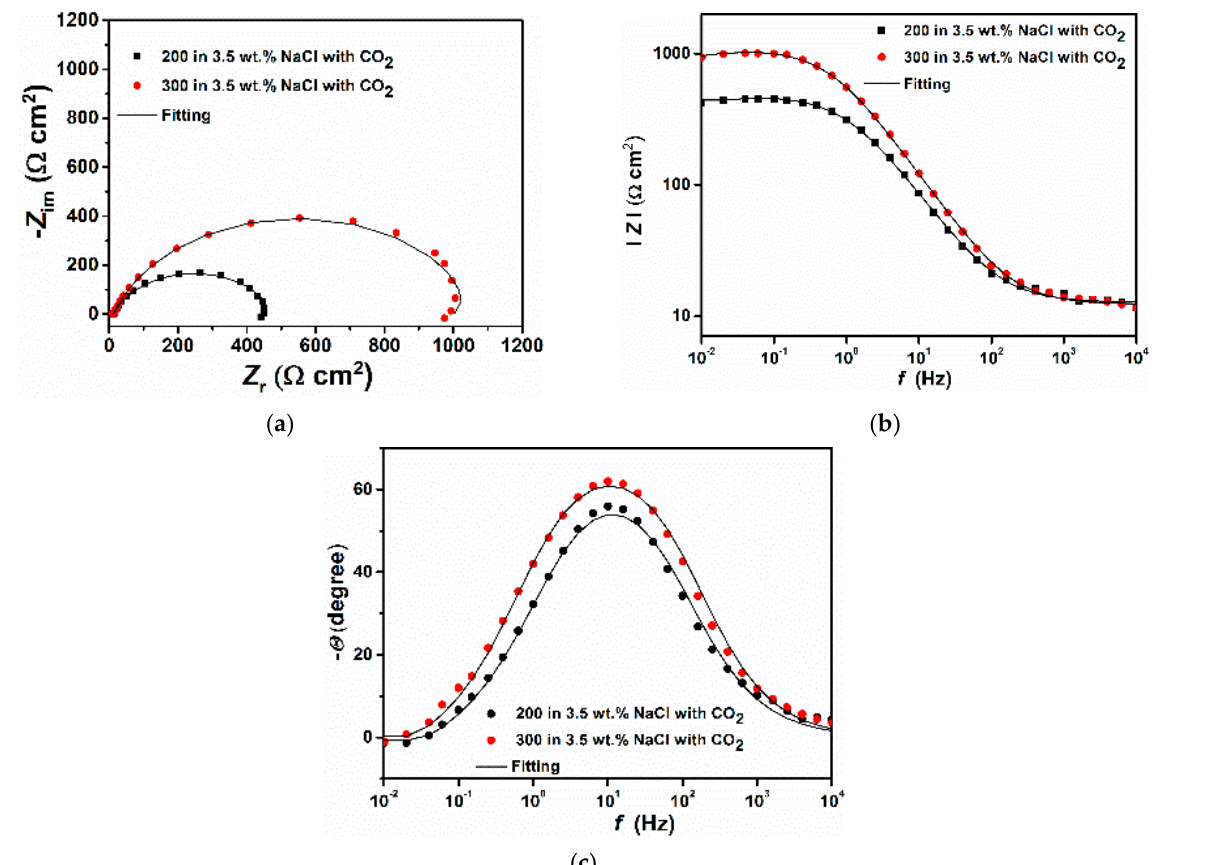
Figure 7. EIS plots comparing the two different samples after 24 h of immersion in a 3.5wt.% NaCl saturated with CO 2 . ( a ) Nyquist, ( b ) Bode, and ( c ) Phase angle. Table 6. Electrochemical impedance parameters of the steels after 24 h of immersion in a 3.5wt.% NaCl aqueous solution saturated with CO 2.